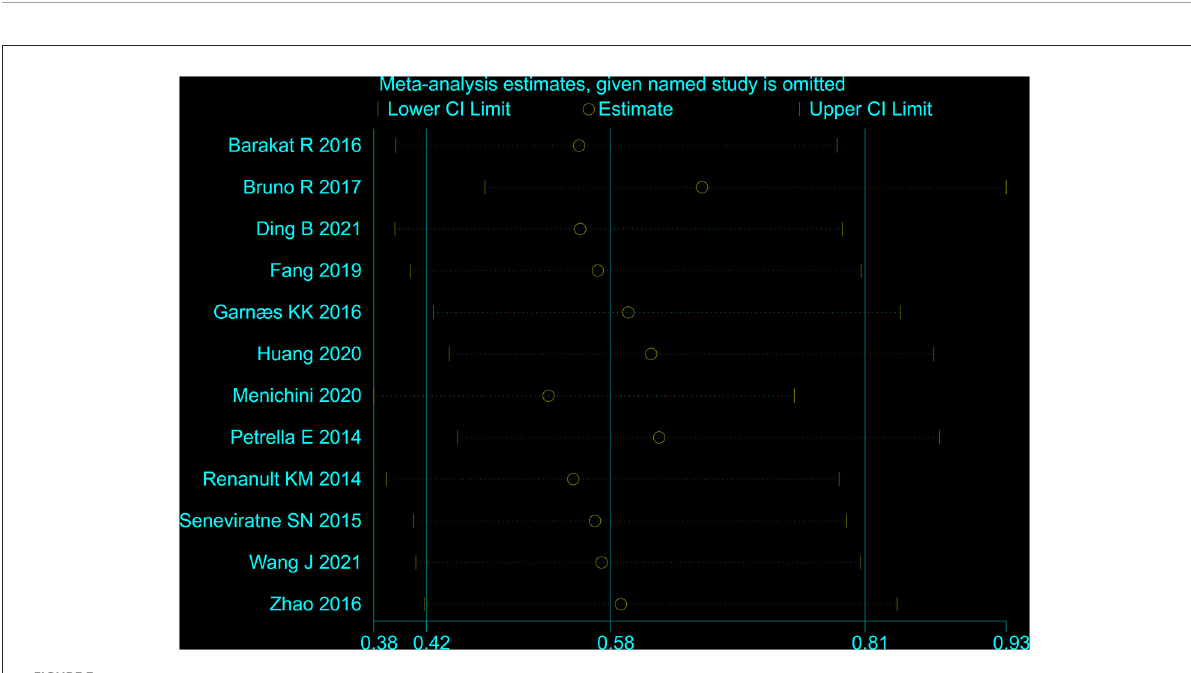
FIGURE3 The result of the sensitivity